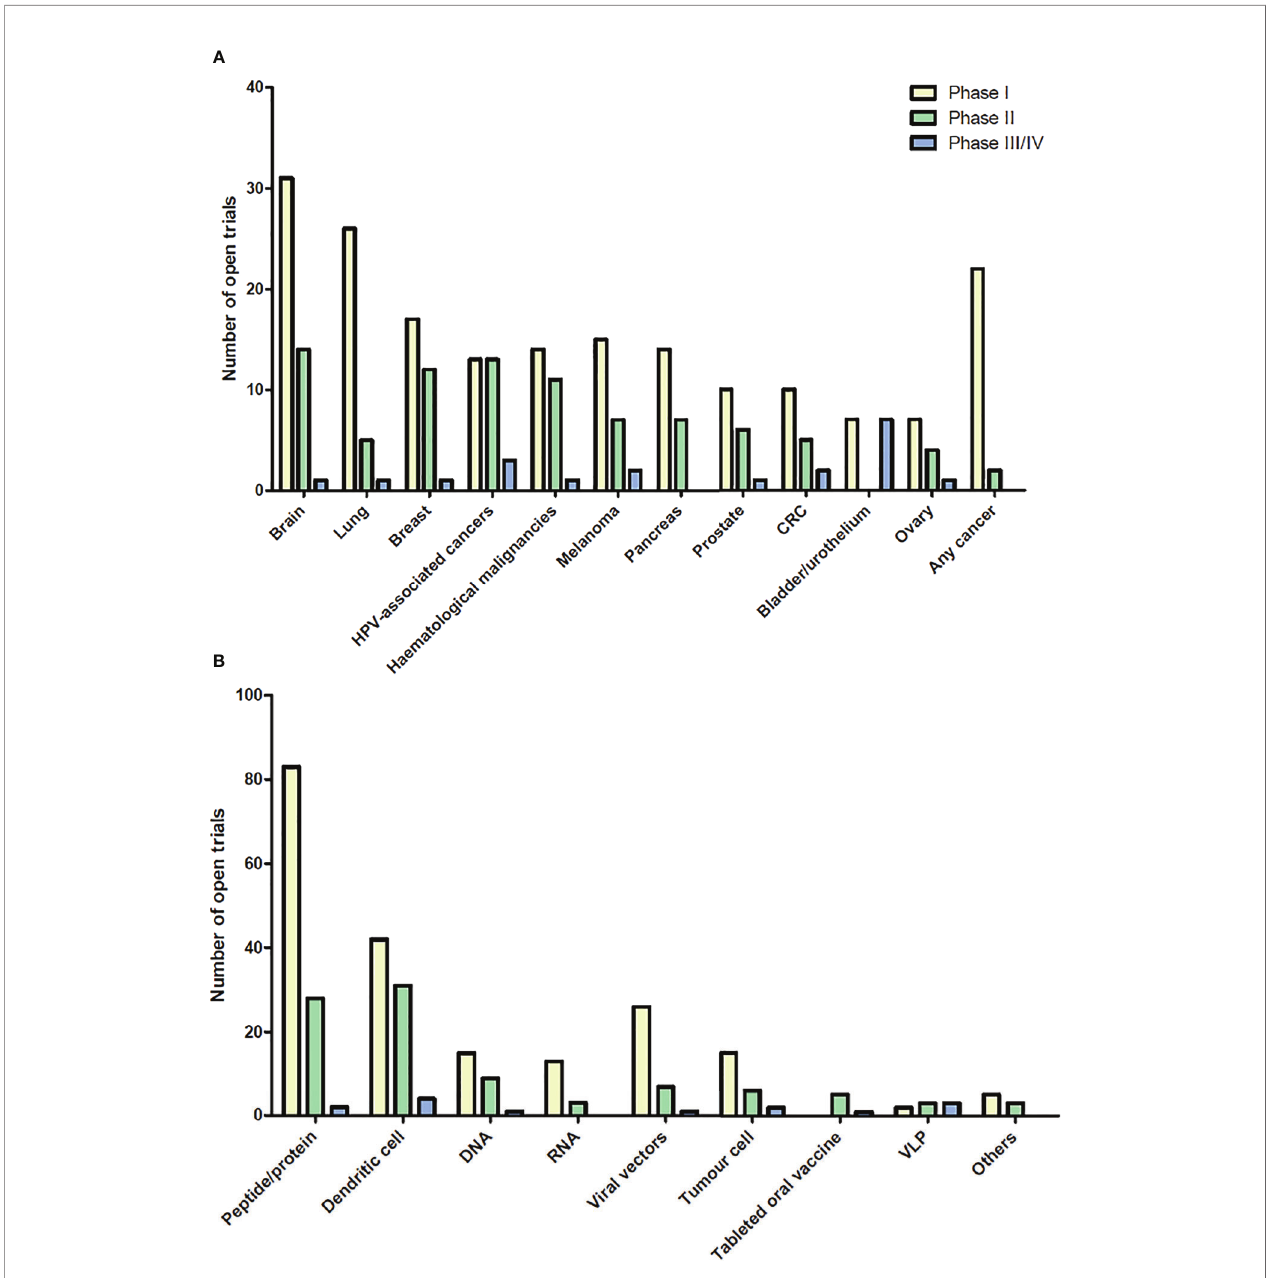
FIGURE 1 | Open cancer vaccine trials. Cancer vaccine trials listed as open at ClinicalTrials.gov on August 2020. The number of trials for each cancer type (A) and for each vaccine type (B) are shown in the bar graph subdivided into phase I, II, and III/IV. Viral vector vaccines include adenovirus and poxvirus, but also trials using yeast-loaded antigens and one using Salmonella-loaded antigens. Cancers with less than 5 open clinical trials are not shown. “ In situ vaccinations ” (intralesional injection of immune- modulatory molecules) are not included in these graphs. HPV, Human Papilloma Virus; CRC, colorectal cancer; VLP, virus like